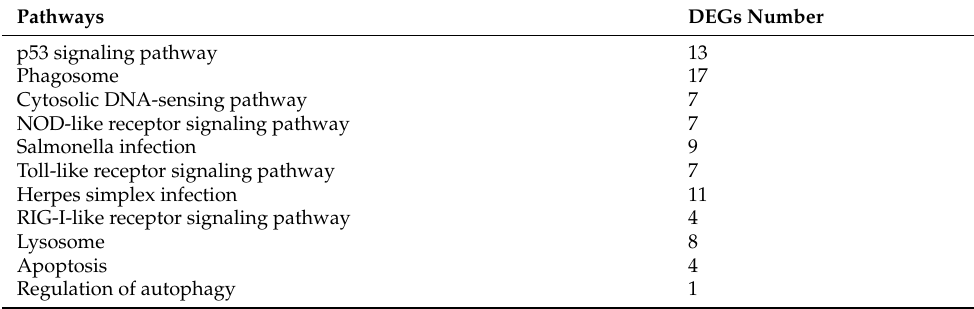
Table 2. Summary of enriched immune-related signaling pathways.